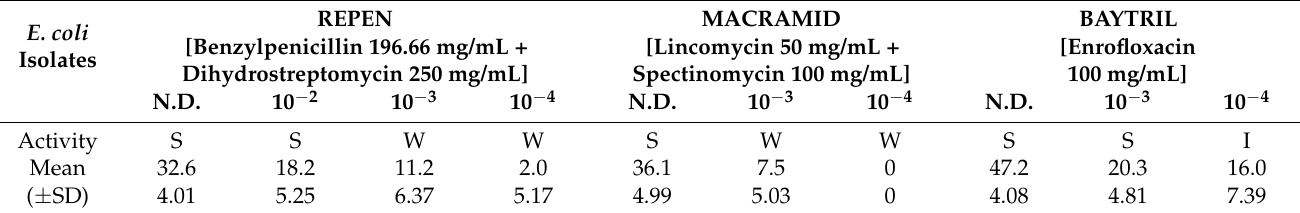
Figure 6. Example of sensitivity/resistance of E. coli isolated strains against the Repen antibiotic on Petri dishes after 48 h of incubation. Table 4. Antimicrobial activity of three antibiotics commonly used on cattle with respect to 23 E. coli isolates. Data interpretation in Section 4.6. Here are reported the mean halo diameter calculated for each column ± SD according to Mazzarrino et al. [26].